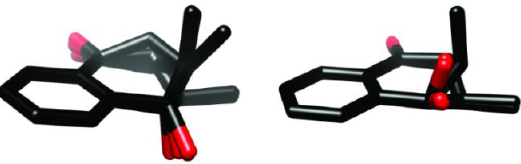
Figure 2. The solution conformations of compounds 2 , to the left, and that of 3 , to the right, as determined by combined theoretical and solution NMR conformational analysis (NAMFIS) for chloroform solution.